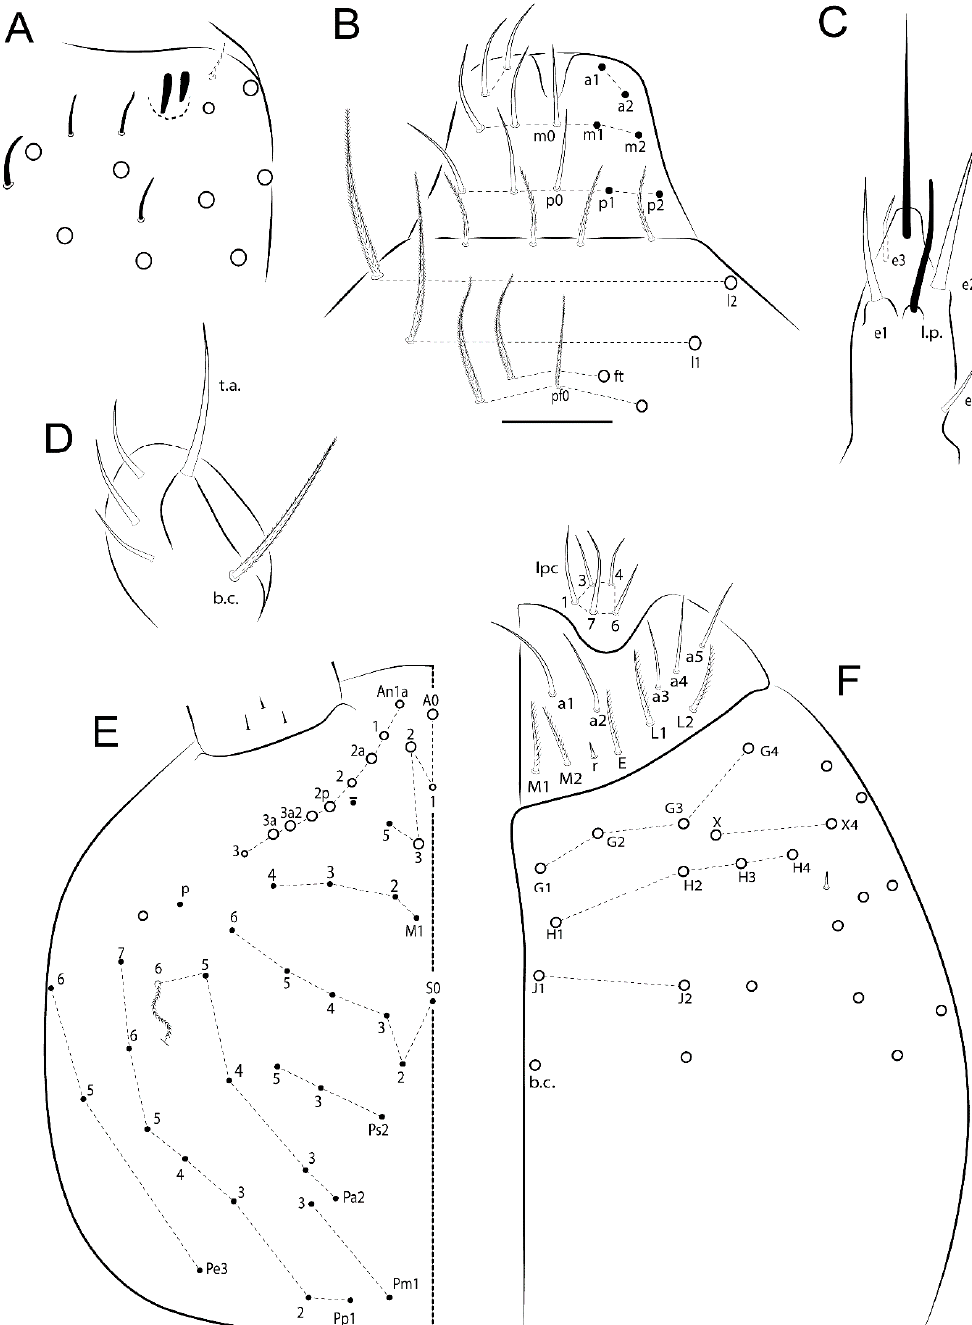
Figure 58. Pseudosinella pusilla sp. nov.: head. ( A ) Ant III apical organ (lateral view); ( B ) chaetotaxy of clypeus, prelabrum, and labrum; ( C ) labial papilla E (right side); ( D ) maxillary palp and sublobal plate (left side); ( E ) head dorsal chaetotaxy (left side); ( F ) labial proximal chaetae, basomedian and basolateral labial fields, and complete postlabial chaetotaxy (right side).